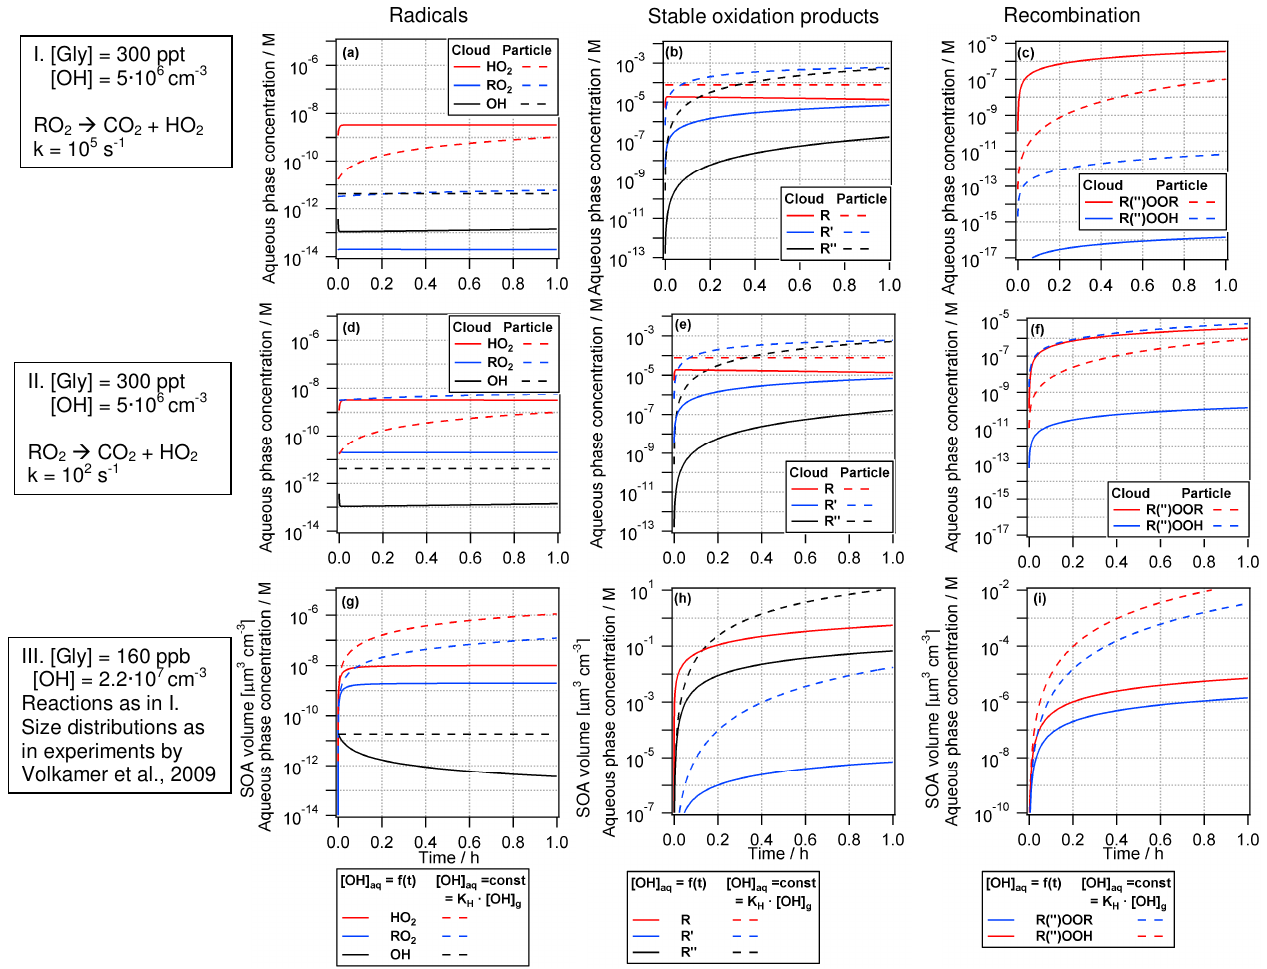
Fig. 3. Predicted concentration profiles of aqueous phase concentrations reactive intermediates (radicals) (a, d, g) , stable oxidation products (b, e, h) and recombination products (c, f, i) simulated with the reaction scheme in Table 4. “Cloud” refers to dilute aqueous phase conditions with drop diameters D =20µm, LWC=0.4gm − 3 , N droplets =100cm − 3 ; “particle” to a more concentrated aqueous phase with aqueous particles with diameters D =100nm, LWC=20µgm − 3 , N particles =5000cm − 3 . Top panel (a–c): the decay rate of peroxy radicals has been assumed as 10 5 s − 1 (Table 4) (Neta et al., 1990). Middle panel (d–f): the decay rate of peroxy radicals has been assumed as 10 2 s − 1 (Table 4) (Neta et al., 1990). Bottom panel (g–i): same mechanism and rate constants as for top panel but initial gas phase concentrations as used in experiments by Volkamer et al. (2009) ([Glyoxal] gas =160ppb; [OH] gas =2.2 × 10 7 cm − 3 ). [OH] aq = f (t) includes the kinetic description of OH transfer into the aqueus phase (as used for all other simulations); [OH] aq =const. assumes a constant OH concentration that implies thermodynamic equilibrium with the gas phase at all times [OH] aq = K H (OH) · [OH] gas (Sect.